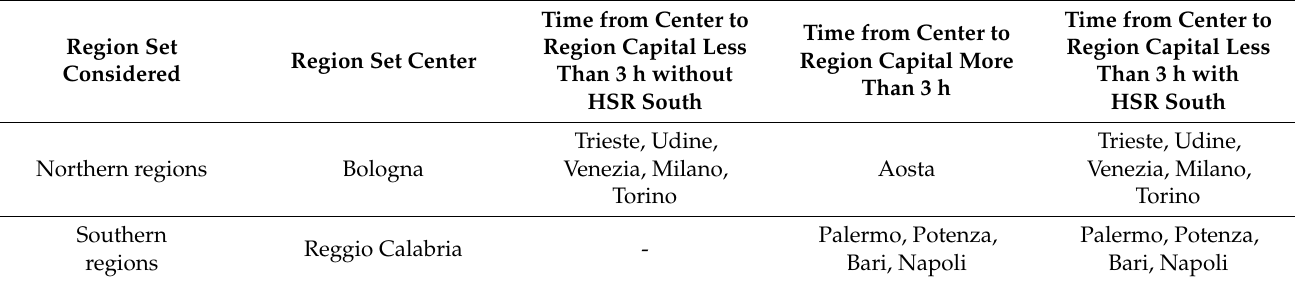
Table 2. Accessibility of Southern and Northern Italian